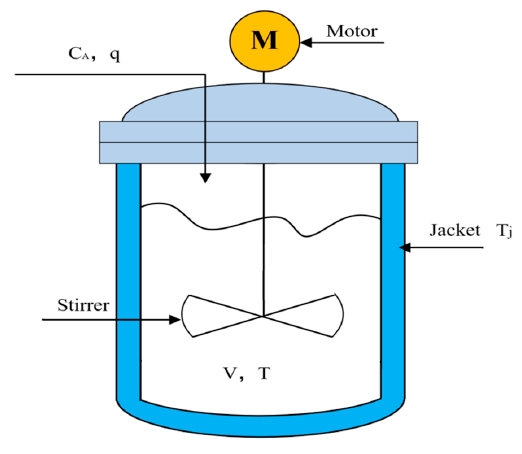
Figure 1. Reactive kettle structure.